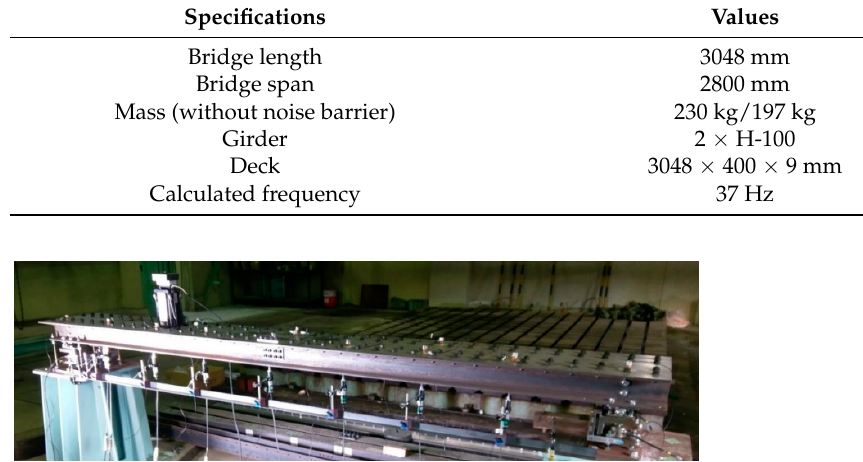
Table 1. Specifications of model bridge.